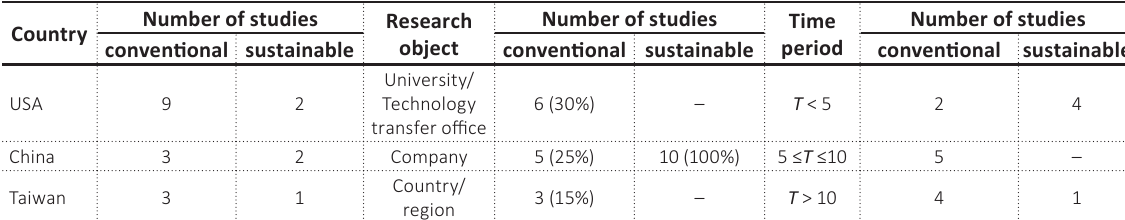
Table 4. A comparative review of the data used